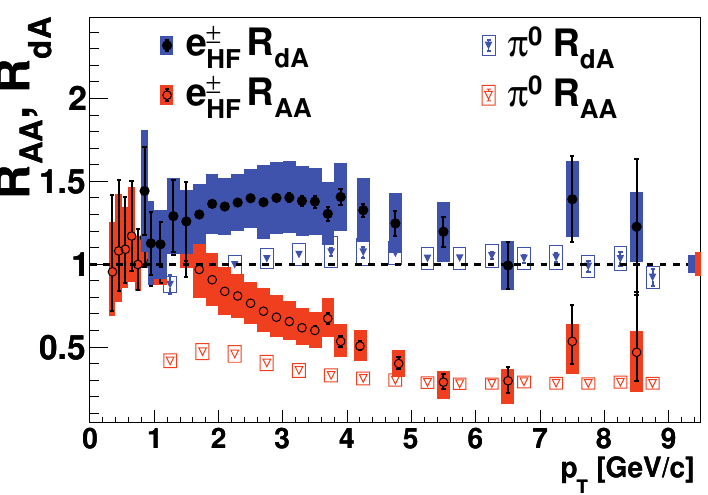
Figure 2. The nuclear modification factors R dA and R AA for minimum bias d + Au and Au + Au collisions measured by the PHENIX experiment, for the π 0 and non-photonic electrons. Taken from Ref.